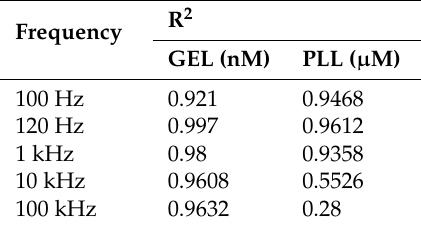
Figure 4. Mean impedance values ( a ) and % impedance variation ( b ) for cells immobilized in Bactoagar matrix treated with nM DA concentrations (1, 10, 50, 100, 200 nM) at five different frequencies. Table 2. R 2 values for mean cell impedance responses in gel for nM DA and in PLL for µ M DA